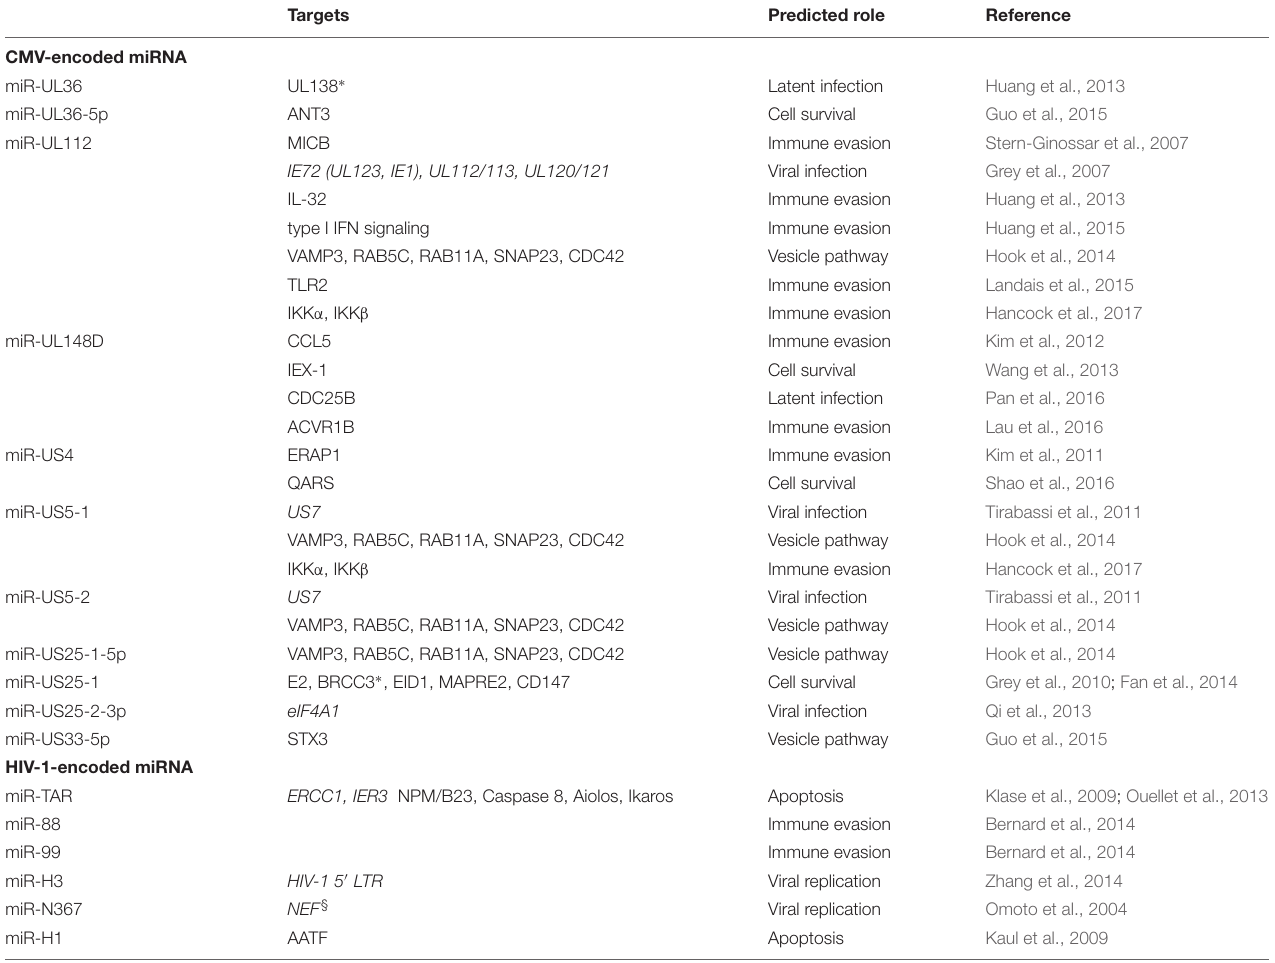
TABLE 1 | HCMV and HIV-1 microRNAs with potential role in viral infection and pathogenesis.